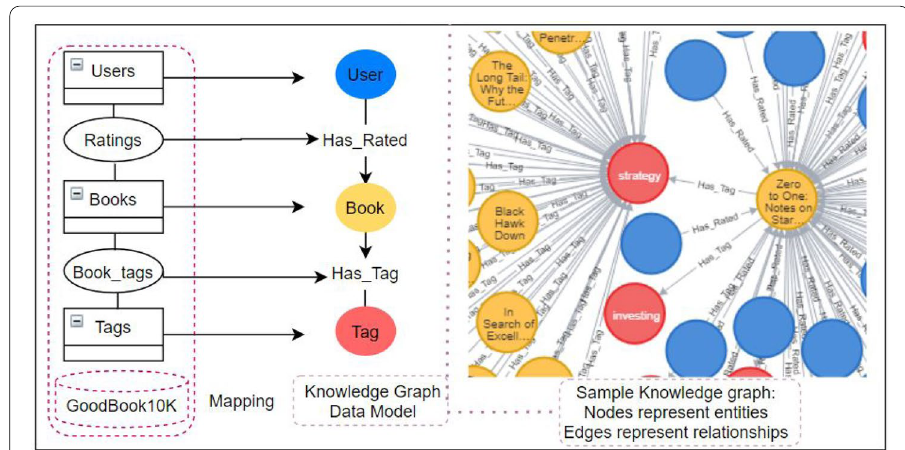
Fig. 6 Modeling Relational Database GoodBook-10K to Knowledge Graph DataBase using Neo4j